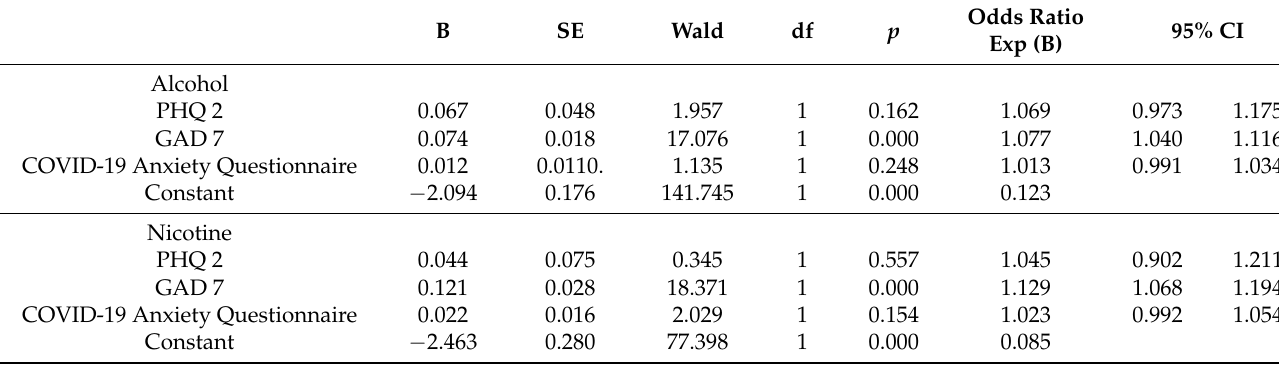
Table 4. Model coefficients binominal logistic regression changes in alcohol and nicotine